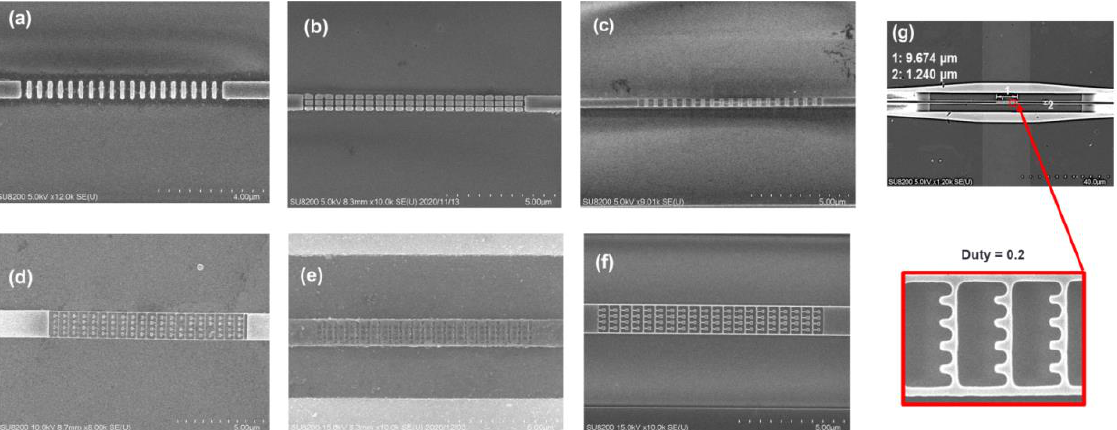
Figure 9. SEM images of fabricated BG RI sensors: ( a ) SW, ( b ) MS-SW, ( c ) suspended ladder, ( d ) CSAW formed by lift-off method, ( e ) CSAW formed by inverse exposure with not-fully etched or ( f ) with fully etched, and ( g ) SAW at duty of 0.2.